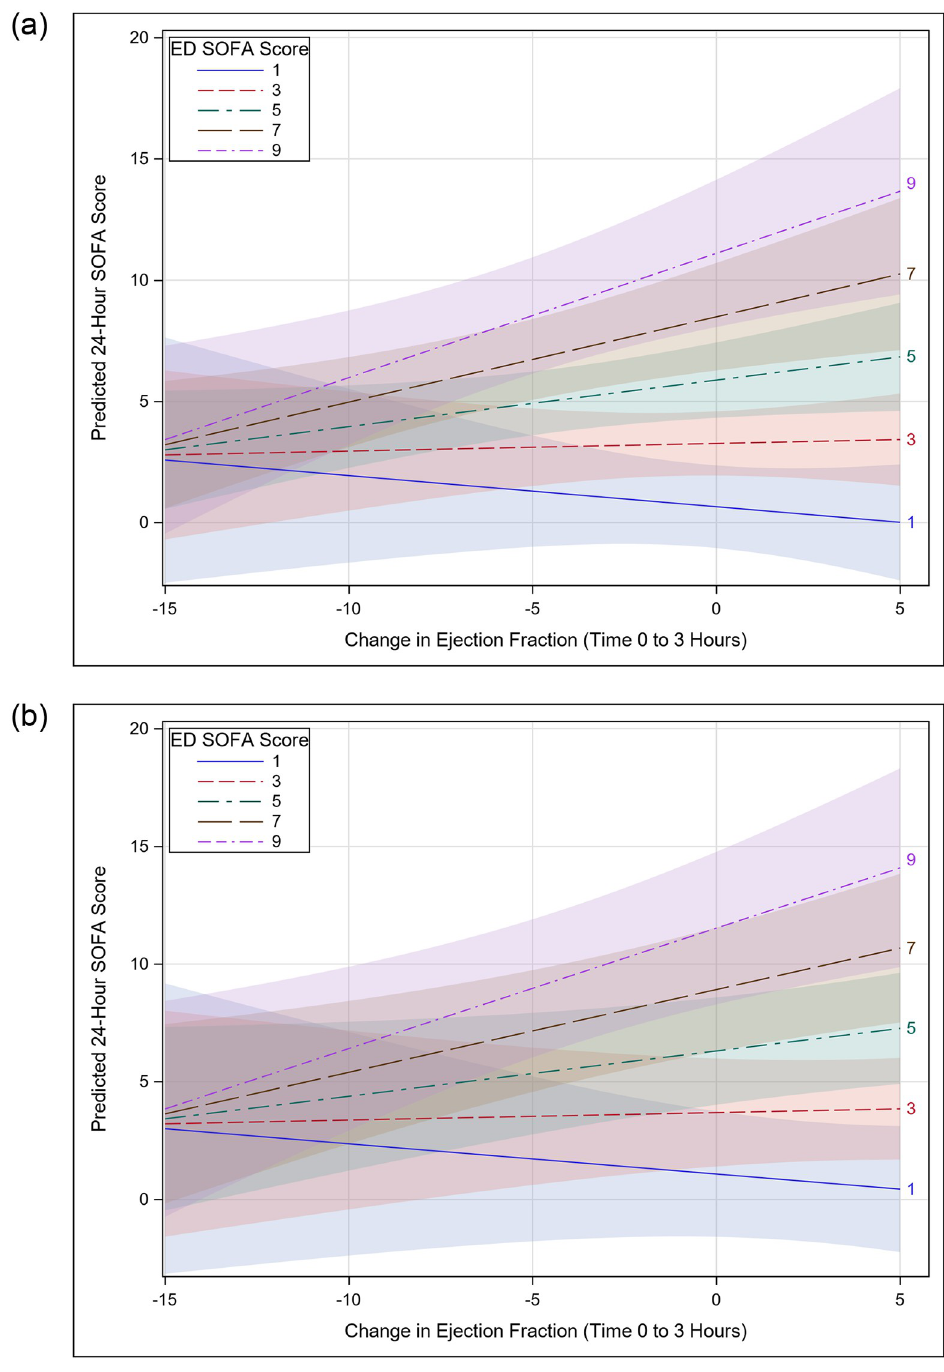
Fig 2. Interaction plot of change in LVEF from 0–3 hours with ED SOFA score. Interaction plot showing that the influence of change in left-ventricular ejection fraction on predicted SOFA Score at 24-hours varies by baseline (ED) SOFA Score, adjusted for age, troponin-I, Average change in E/e’ from 0-3hrs, and baseline inferior vena cava (IVC) collapsibility; bands represent 95% CIs. Panel A represents patients with IVC collapse � 50%; Panel B represents patients with IVC collapse <